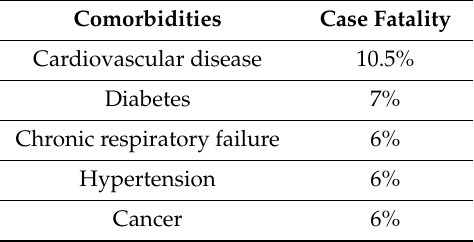
Table 4. Comorbid case fatalities of COVID-19 [79].